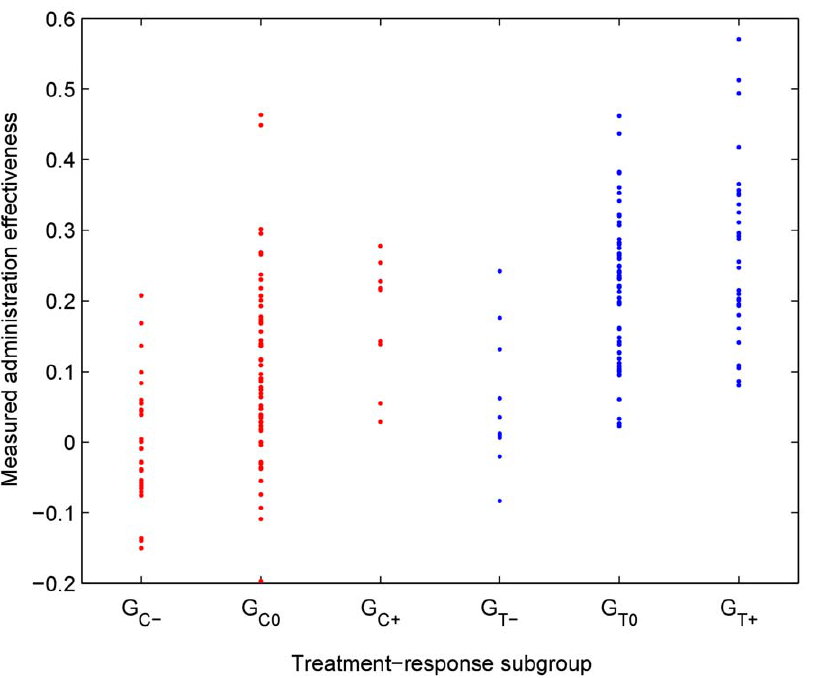
Figure 4. The spread of observed (measured) treatment responses (vertical axis) of the participants in the simulated reference trial across the six sub-groups (horizontal axis; see the ‘‘Study Design and Outcome Model’’